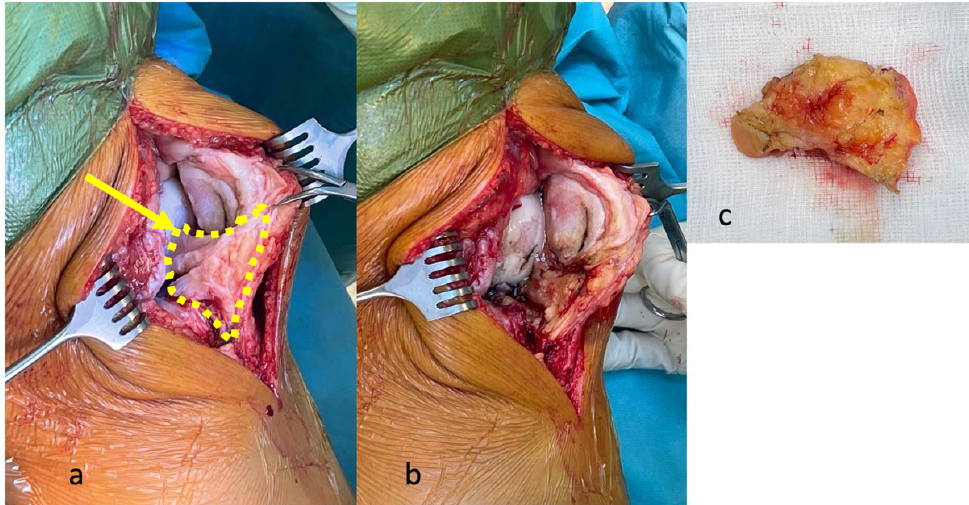
Figure 3. Intraoperative visualization of the IFP during TKA: ( a ) intraoperative view of the IFP during implantation of a TKA (yellow dotted line) with infrapatellar plica (lig. mucosum), ( b ) significant improvement of the intraoperative overview after resection of the IFP, ( c ) view on the resected IFP with its dorsal synovial covering, IFP–infrapatellar fat pad.